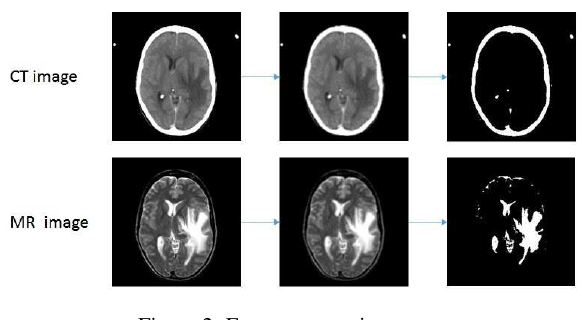
Figure 2. Feature extraction stage